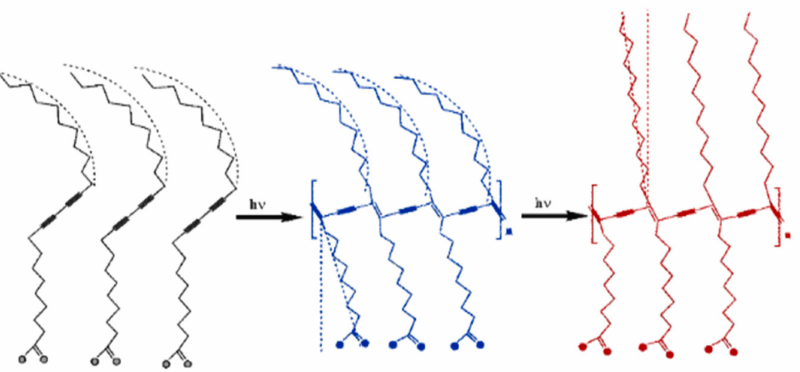
Figure 1. Schematic drawing of the 3 phases of PDA. From ( left ( black )): the monomeric molecules of DAs prior to irradiation; ( blue ): the blue phase of PDA polymerized by electromagnetic radiation; and on the ( right ( red )): the red phase of PDA